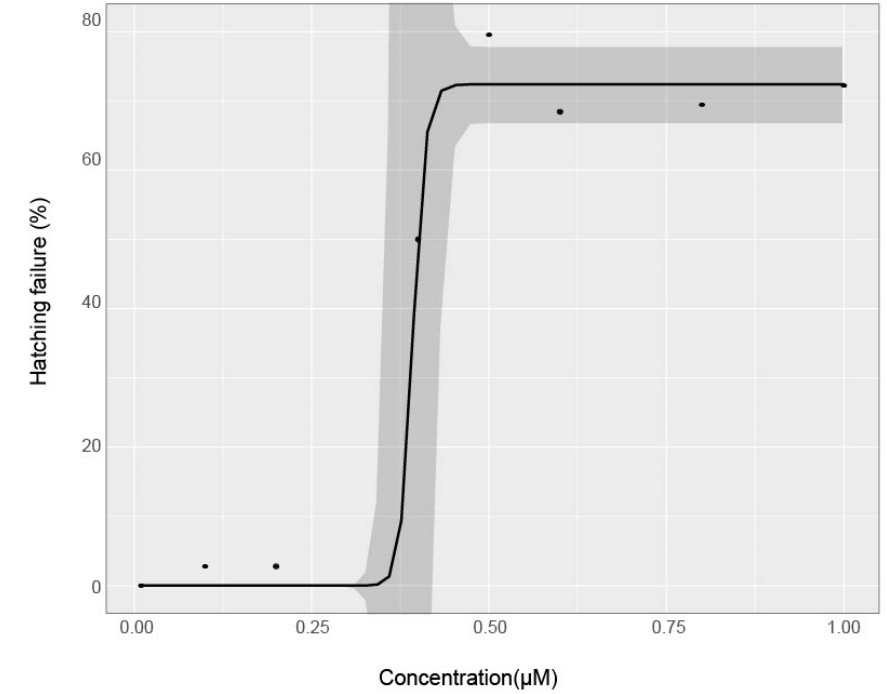
Figure 5. Hatching failure across concentrations for Abamectin chorion-on treatment. Hatching failure was measured at 120 hpf. Points are mean % incidence of hatching failure across replicate plates for each concentration. A logarithmic regression model was fit to the data and shaded areas indicate 95% confidence intervals for model fit.